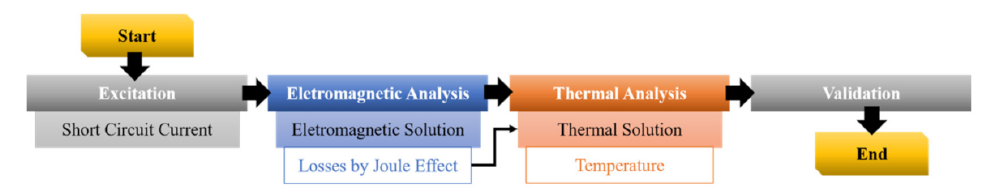
Figure 8. Thermo-magnetic coupling.